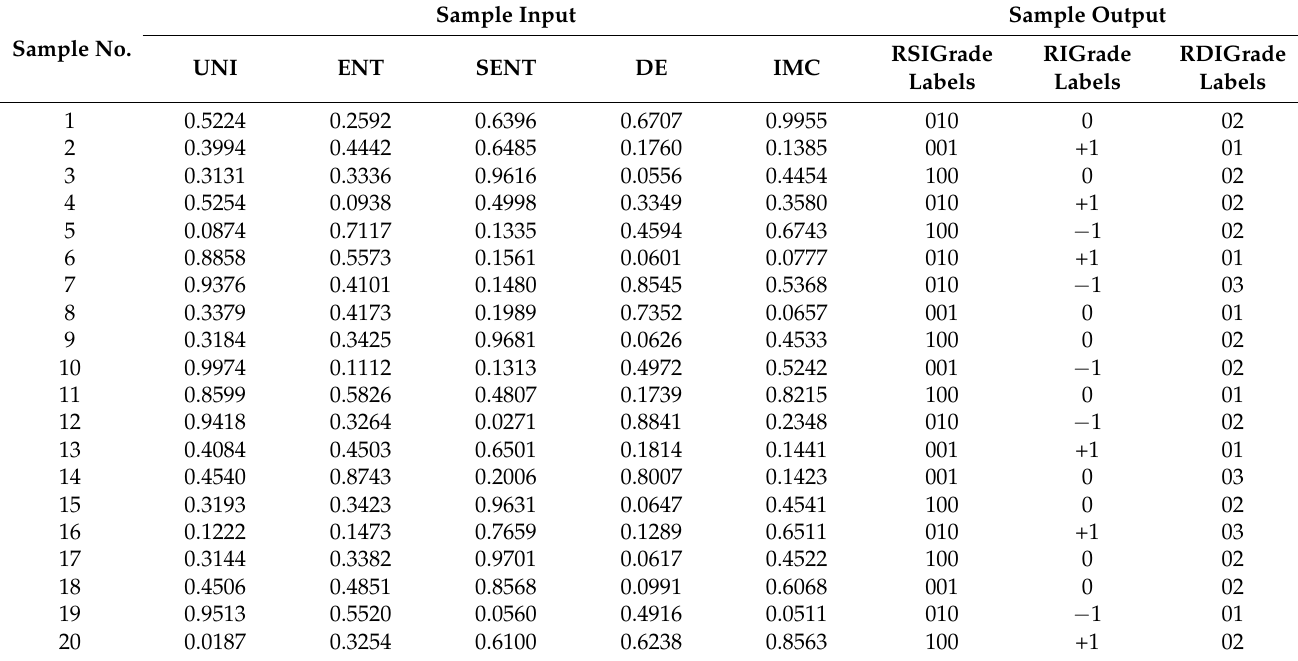
Table 1. Elite sample set for forecast of metallurgical properties of pellets.